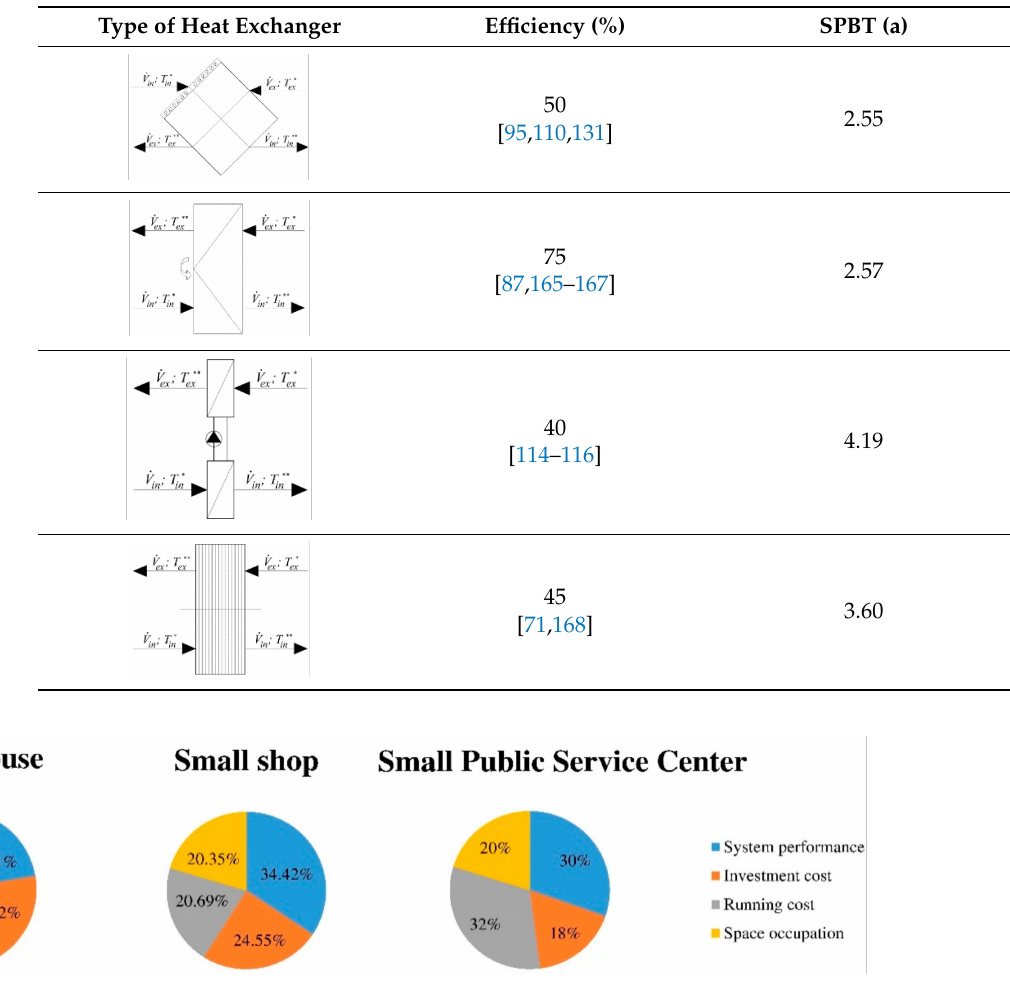
Figure 16. Preference results of different decision makers for evaluation indexes